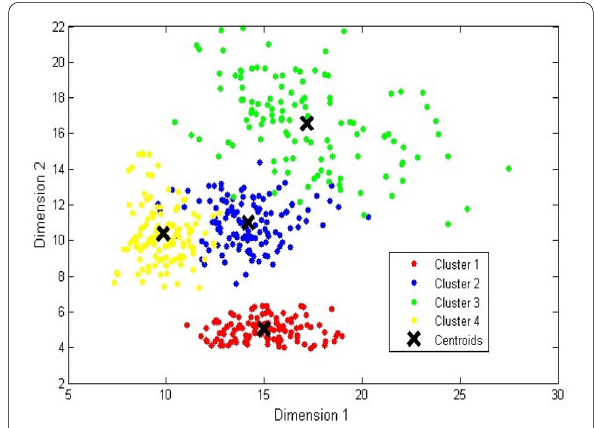
Figure 6 Visualization of the feature